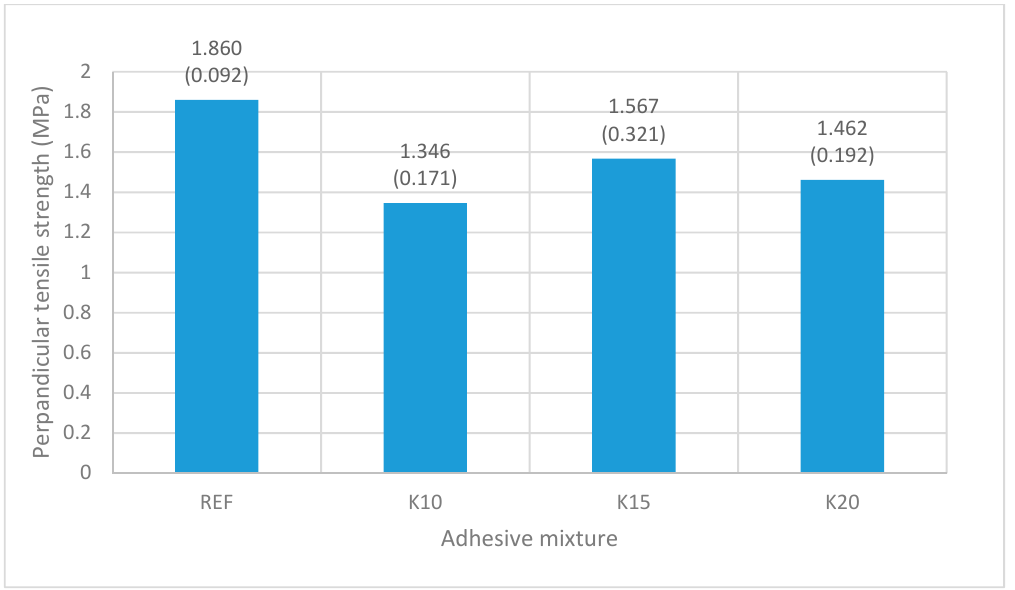
Figure 7. Effect of adhesive mixtures on perpendicular tensile strength of plywood panels (values in parenthesis are standard deviations).